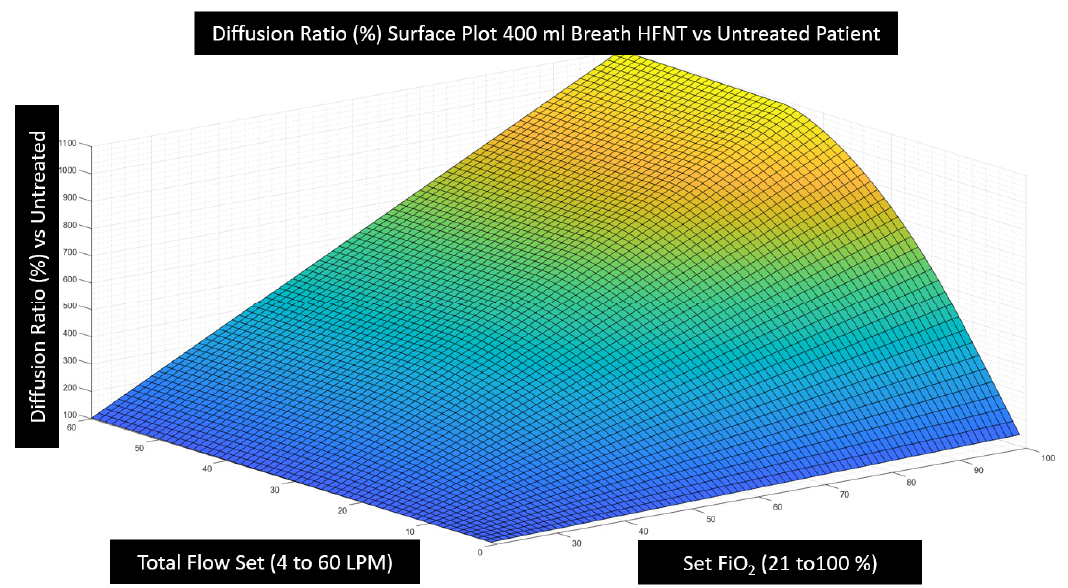
Figure 8. The values in Figure 7 are shown as a surface plot. Effectiveness of the treatment is maximized with increasing the set flow and increasing F i O 2 . If the set flow is below the PIF (36 LPM), we see the diffusion ratio of the treatment is diminished toward no treatment (100%).